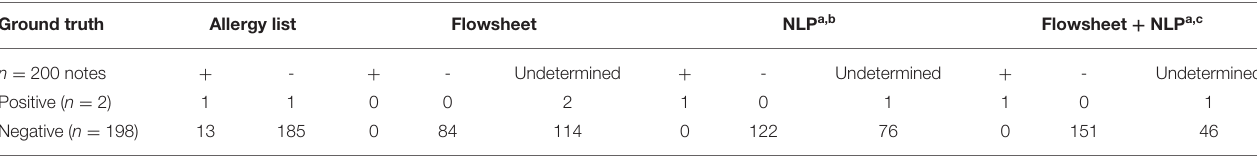
TABLE 3 | Confusion matrix of different allergy information sources. Ground truth